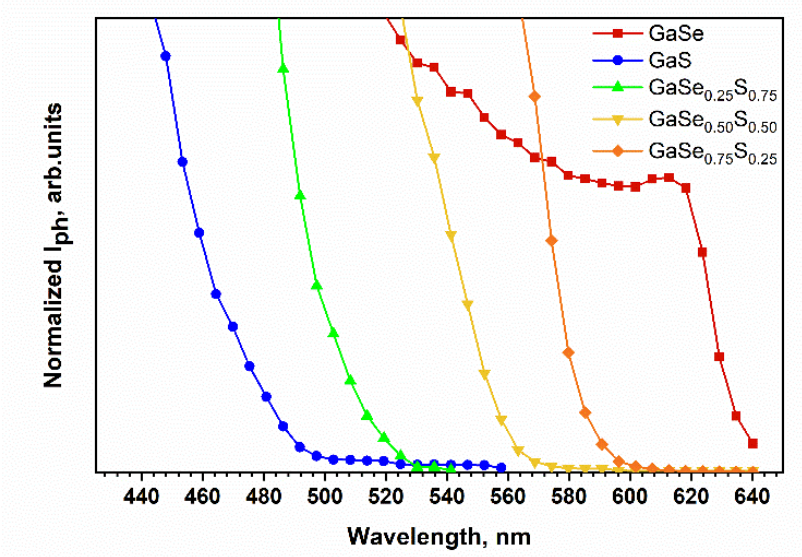
Figure 4. Spectral dependences of the photocurrent of the as-grown GaSe 1 − x S x flakes.